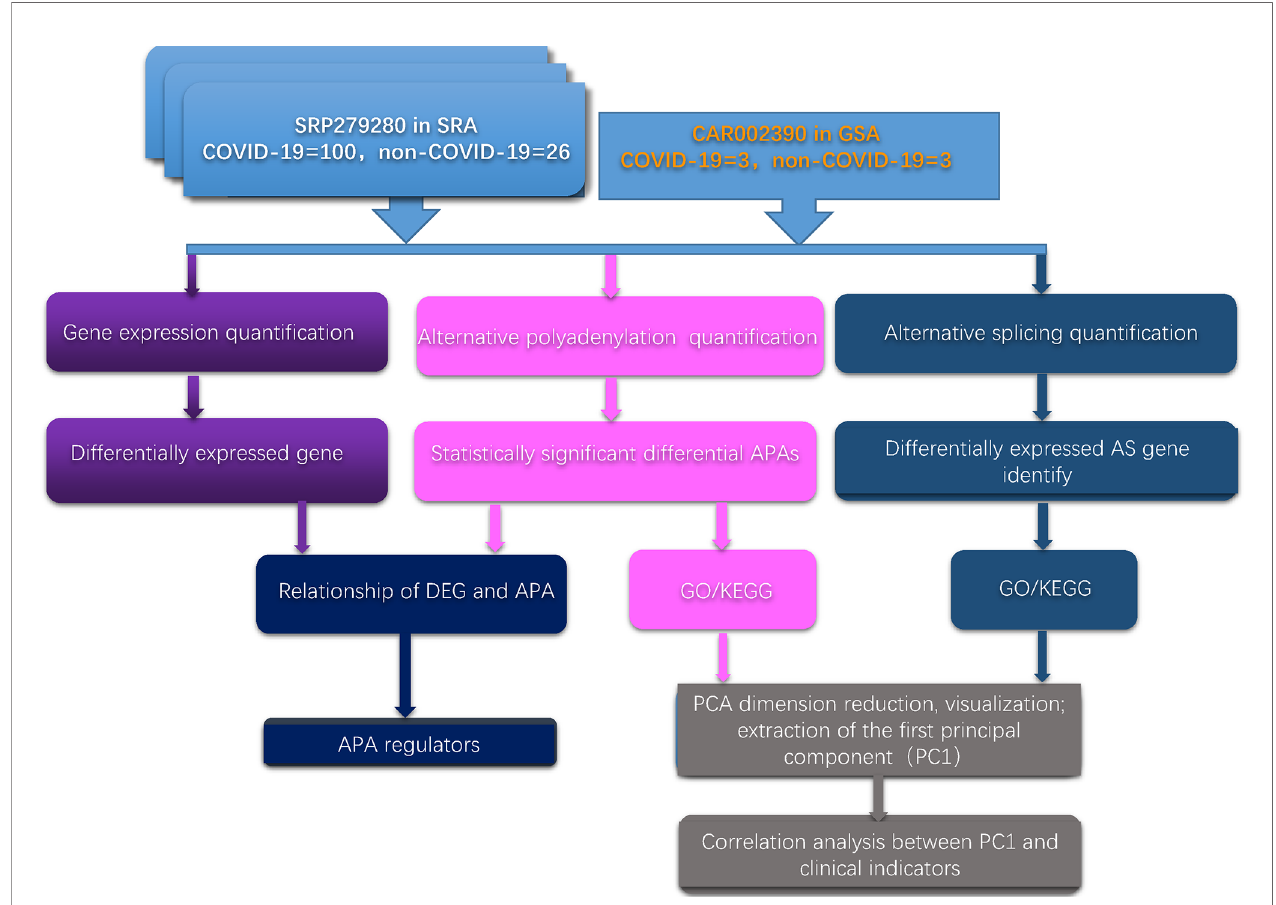
FIGURE 1 | Schematic fl ow chart demonstrating the computational